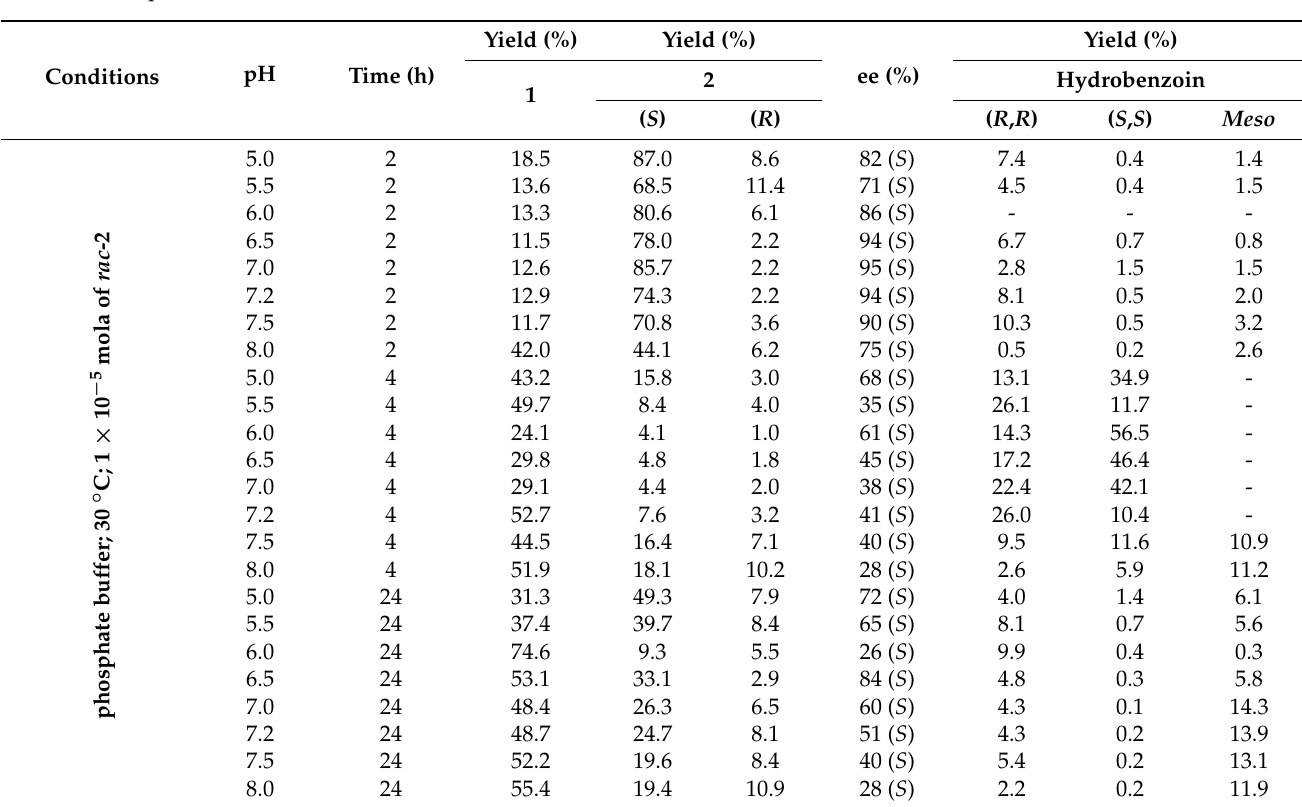
Table 7. Deracemization of Rac - 2 Catalyzed by A. pullulans Strain DSM 14940 and DSM 14941 in Phosphate Buffer at Different pH Values.